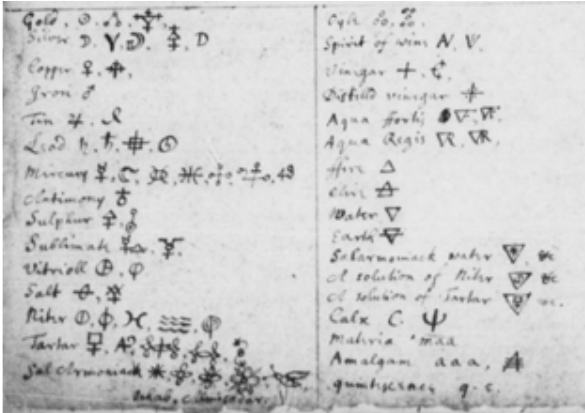
Figure 1. An autograph note by Newton with the alchemical sym- bols in the Liber Mercuriorum Corporum . Partly taken from “The Chymistry of Isaac Newton”. Reproduced by permission of the Provost and Scholars of King’s